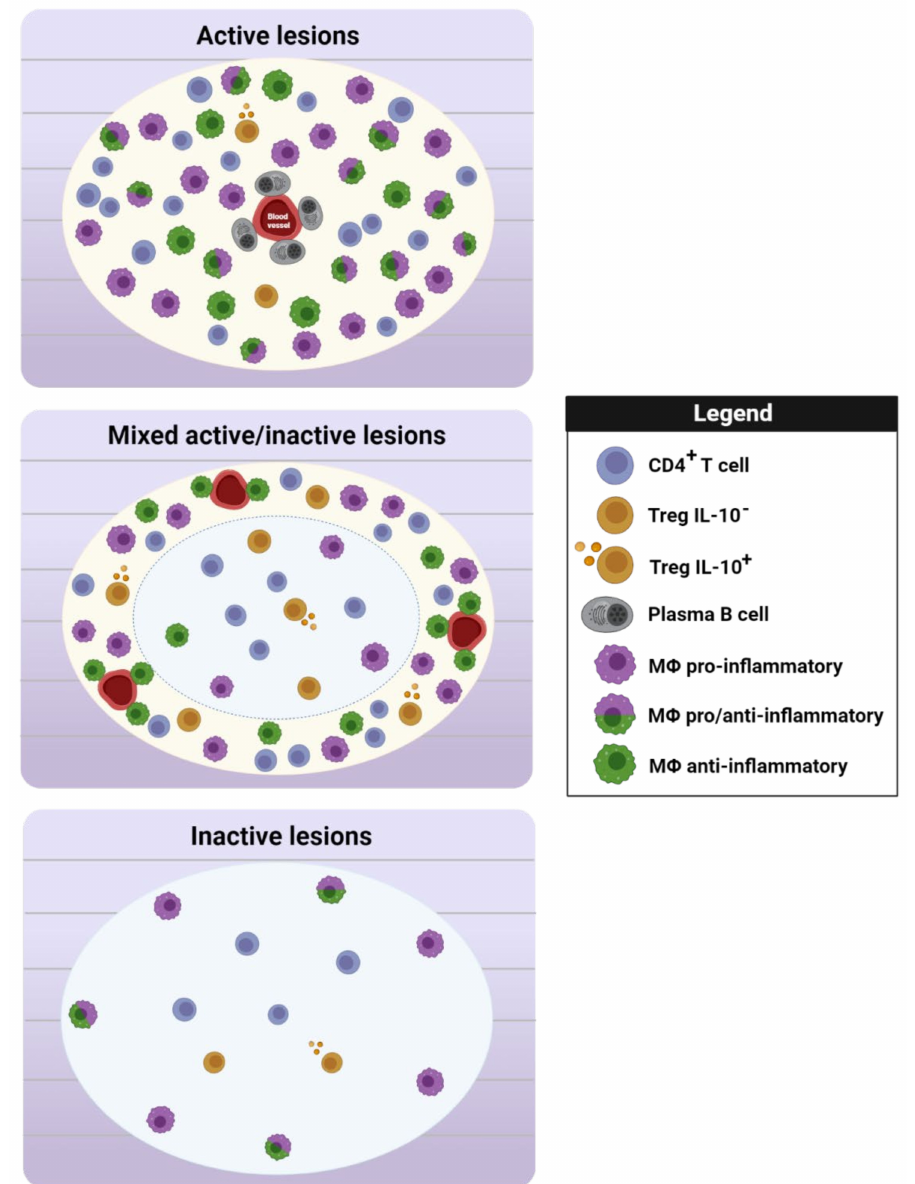
Figure 2. Scheme of the regulatory cells present in MS lesions. The IL-10 + Treg/Treg ratio increases in the plaque of active and inactive lesions and at the rim of mixed active/inactive areas (Zandee et al., 2017). Perivascular CD138 + CD38 + plasma cells act as a source of the anti-inflammatory cytokine IL-10, and they are mainly observed in active lesions (Machado-Santos et al., 2018). In terms of myeloid cells, the distribution of typical markers used to identify pro- or anti-inflammatory cells in demyelinating lesions reveals the presence of myeloid cells with an intermediate activation phenotype (CD40 + /CD206 + cells) in active lesions (Vogel et al., 2013) and the coexistence of pro-inflammatory and regulatory myeloid cells at the rim of both mixed active/inactive and inactive lesions (Vogel et al., 2013; Jackle et al., 2020). However, anti-inflammatory myeloid cells are also observed in active lesions and at the rim of mixed active/inactive lesions (Miron et al., 2013). Legend: CD4 + T cell = CD4 + FoxP3 − ; Treg IL-10 − = CD4 + FoxP3 + IL-10 − ; Treg IL-10 + = CD4 + FoxP3 + IL-10 + ; plasma B cell = CD138 + CD38 + ; M φ pro-inflammatory = iNOS + or CD40 + cells; M φ pro-/anti- inflammatory = CD40 + CD206 + cells; M φ anti-inflammatory = CD206 + or CD163 + cells. Figure created with Biorender.com (accessed on 12 January